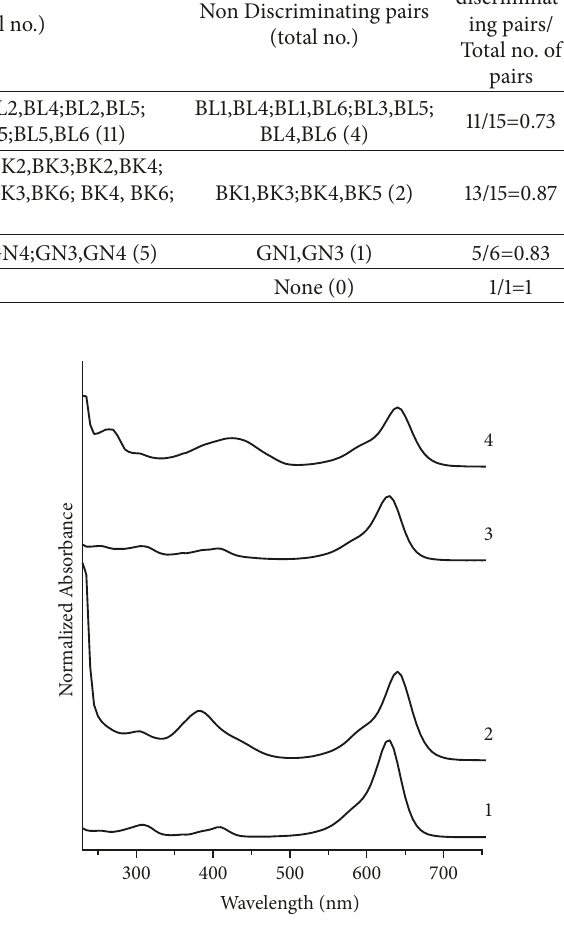
Figure 3: Normalized UV/Visible absorption spectra for green fountain pen inks. 1, 2, 3, and 4 represent samples GN1, GN2, GN3, and GN4,